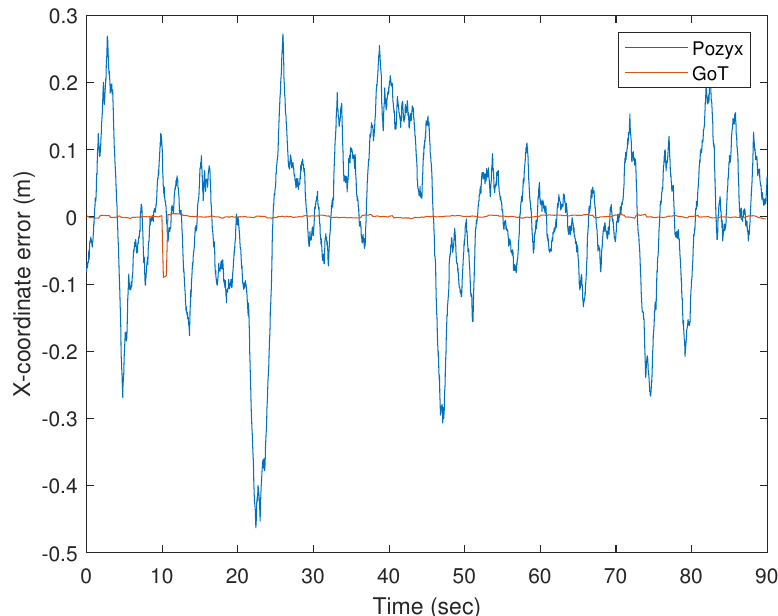
Figure 9. 90 s of recorded X-direction errors from Pozyx (blue) and GoT (red) for ground-truth index 16 for the 1 m